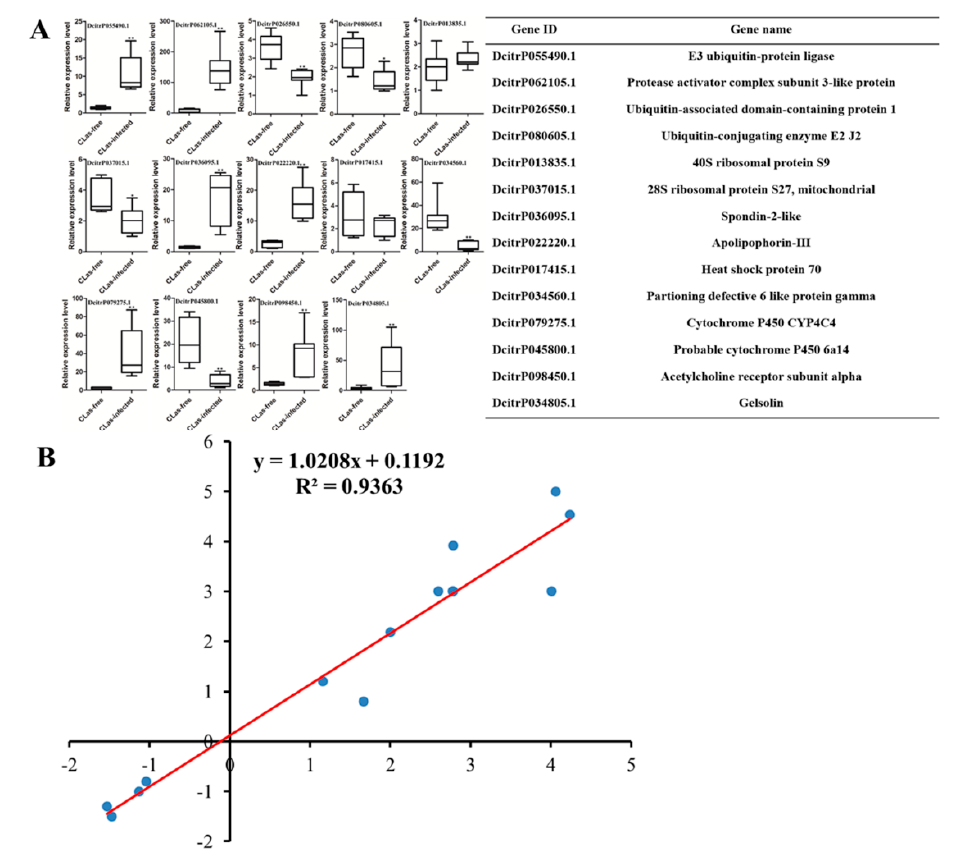
Figure 5. The correlation between the gene expression ratios obtained from the transcriptome data and RT-qPCR data. ( A ) The di ff erential expression levels of 14 di ff erentially expressed genes in the C Las-free and C Las-infected D. citri midgut. The relative expression levels were calculated using the 2 − ∆∆ Ct method. Statistical analysis was performed using the SPSS software. The significant di ff erences are indicated by * ( p < 0.05) or ** ( p < 0.01); ( B ) Lineage analysis between the transcriptome and RT-qPCR data. The ratios obtained by RT-qPCR ( Y -axis) were plotted against the ratios obtained by the transcriptome ( X -axis).